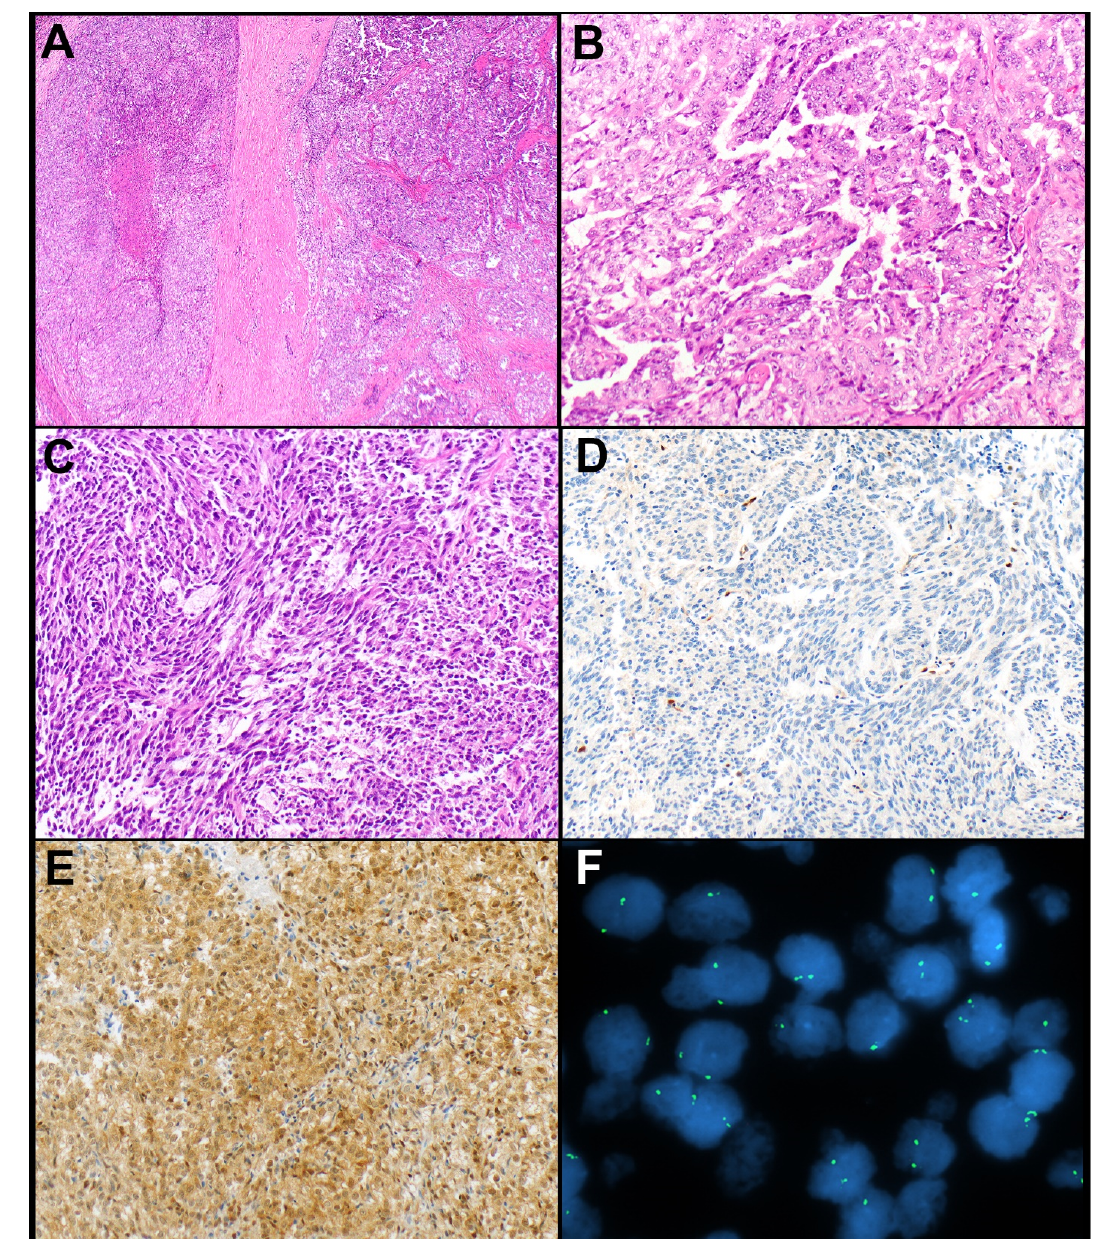
Figure 5. Thymic adenocarcinoma (same case as Figure 1A–C). ( A ) This adenocarcinoma was com- prised of solid (left-hand side and Figure 1A,B) and papillary (right-hand side) patterns. ( B ) Neo- plastic cells are lining thin fibrovascular cores consistent with a papillary growth pattern. ( C ) In some areas, the tumor was comprised of a spindle cell/sarcomatoid component. ( D ) mTAP expres- sion was lost in the tumor cells of the sarcomatoid component (and the solid component that is shown in Figure 1A,B, respectively, not shown), while mTAP expression was preserved in other areas of the tumor ( E ). ( F ) Homozygous deletion of CDKN2A (fluorescence in situ hybridization [FISH], two green signals and no red signal) was observed prepared from the same tumor area that showed loss of expression of mTAP ( D ). FISH studies were not performed in tumor areas that re- vealed expression of mTAP in tumor cells. Magnification, H&E × 40 ( A ), × 200 ( B , C ), mTAP × 200 ( D , E ), CDKN2A FISH × 1000 (oil) ( F ).